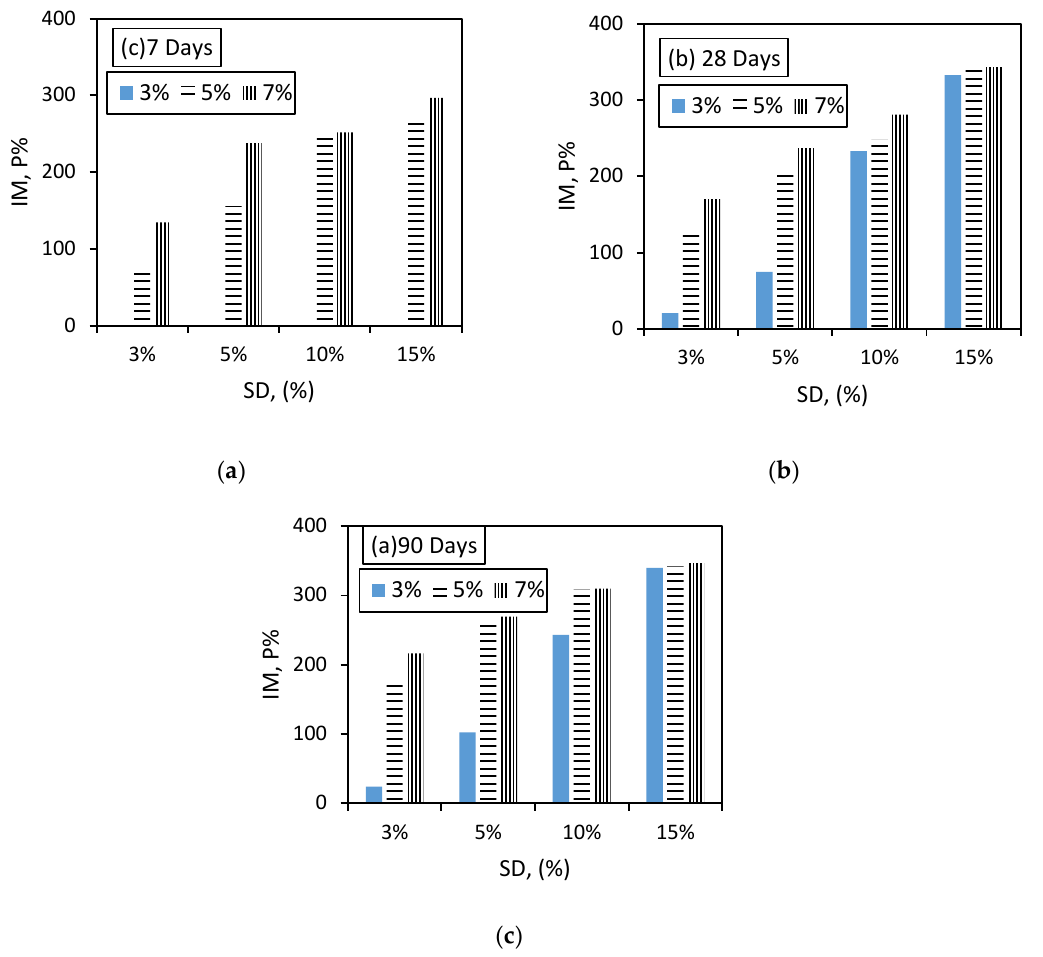
Figure 11. Effect of sawdust addition on IMP values after exposure to sulphate: ( a ) 90 days curing; ( b ) 28 days curing; ( c ) 7 days curing.